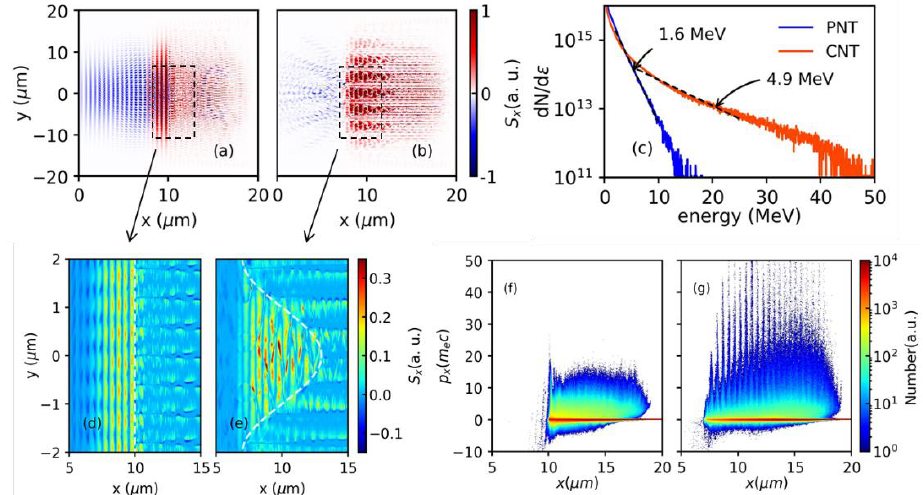
Figure 2. Simulation results at 𝑡 = 22 𝑇 0 . ( a , b ) Normalized Poynting flux ( 𝑆 𝑥 ) for the CNT ( a ) and the PNT ( b ), where forward and reflected components are labelled as red and blue, respectively. At this time both incident and reflected components of 𝑆 𝑥 can be observed. ( c ) Energy spectra of hot electrons in the nanowires. ( d , e ) Zoom-in view of Poynting flux near the target front surface. ( f , g ) Phase space ( 𝑝 𝑥 − 𝑥 ) of electrons in the nanowires.